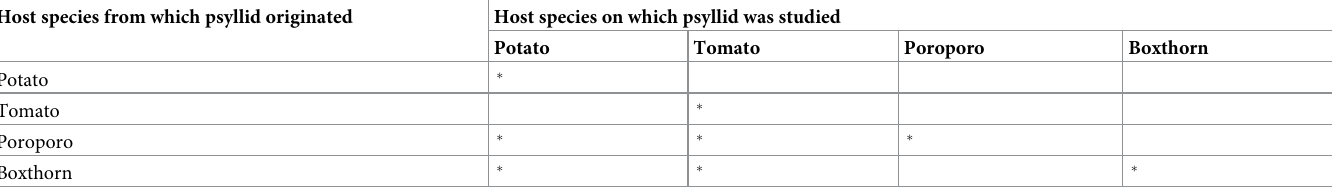
Table 1. A � indicates a combination of originating host species and receiving host species that was studied in the experiment. Host species from which psyllid originated Host species on which psyllid was studied Potato Tomato Poroporo Boxthorn Potato � Tomato � Poroporo